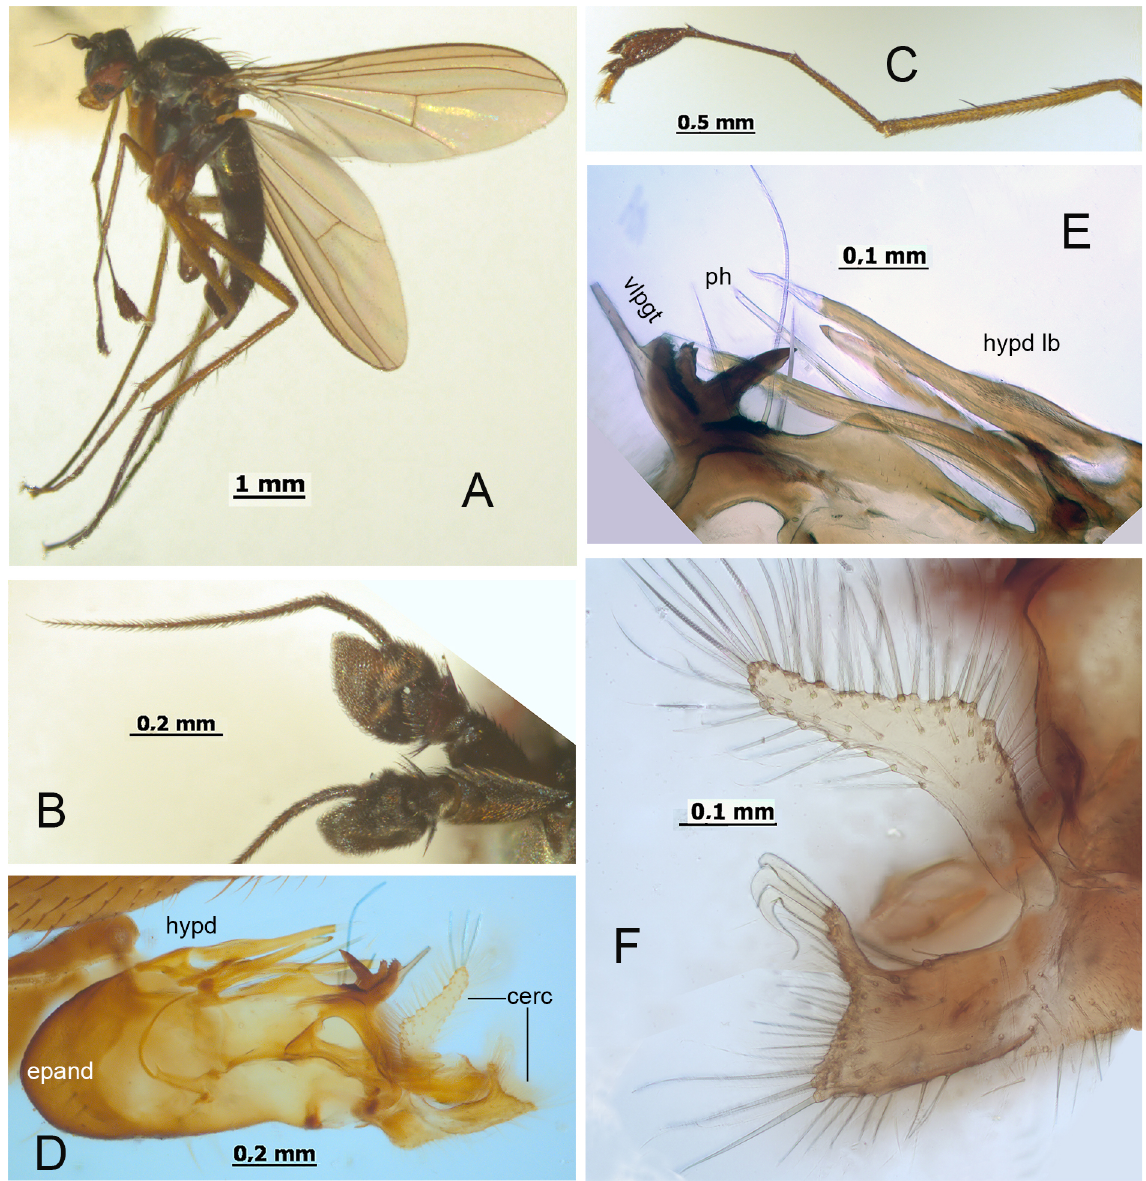
Fig. 3. Hercostomus sanipass sp. nov., ♂, paratype, no date (NMSA). A . Habitus. B . Antenna. C . Fore tibia and tarsus. D . Hypopygium, right lateral view. E . Distoventral appendages of epandrium. F .